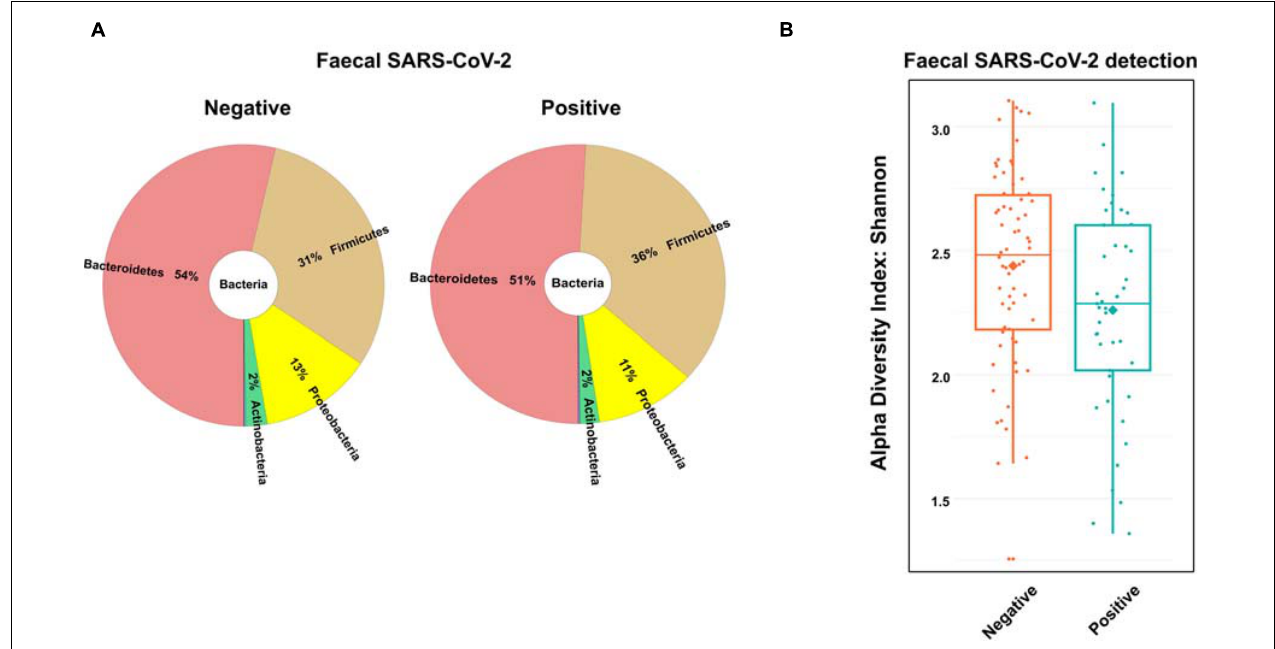
FIGURE 3 | Fecal microbiota composition of the coronavirus disease 2019 (COVID-19) patients according to the presence of SARS-CoV-2 in fecal samples. (A) Main bacterial phyla and (B) box plot of the alpha diversity (measured by the Shannon diversity index) of COVID-19 patients according to the presence of SARS-CoV-2 in fecal